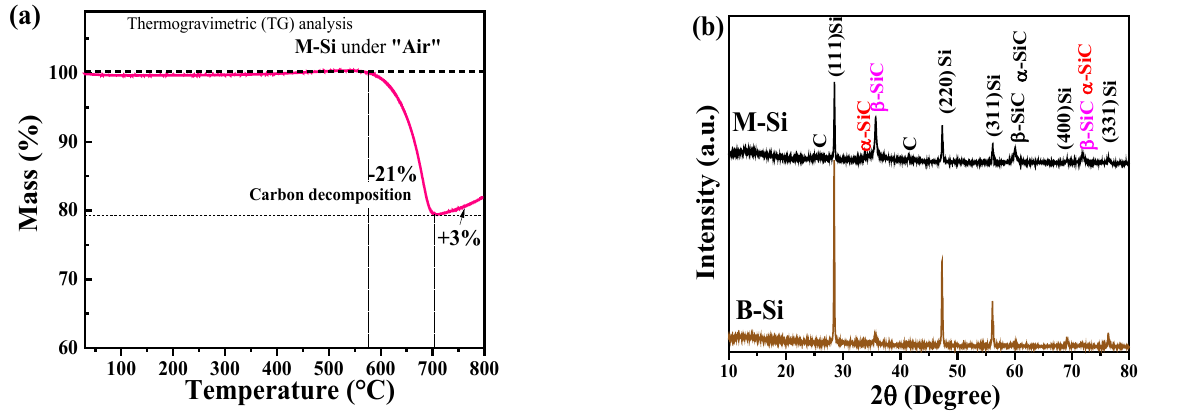
Figure 2. ( a ) TGA curve of M-Si powder in air with a heat rate of 5 ◦ C/min. ( b ) XRD patterns of M-Si and B-Si.